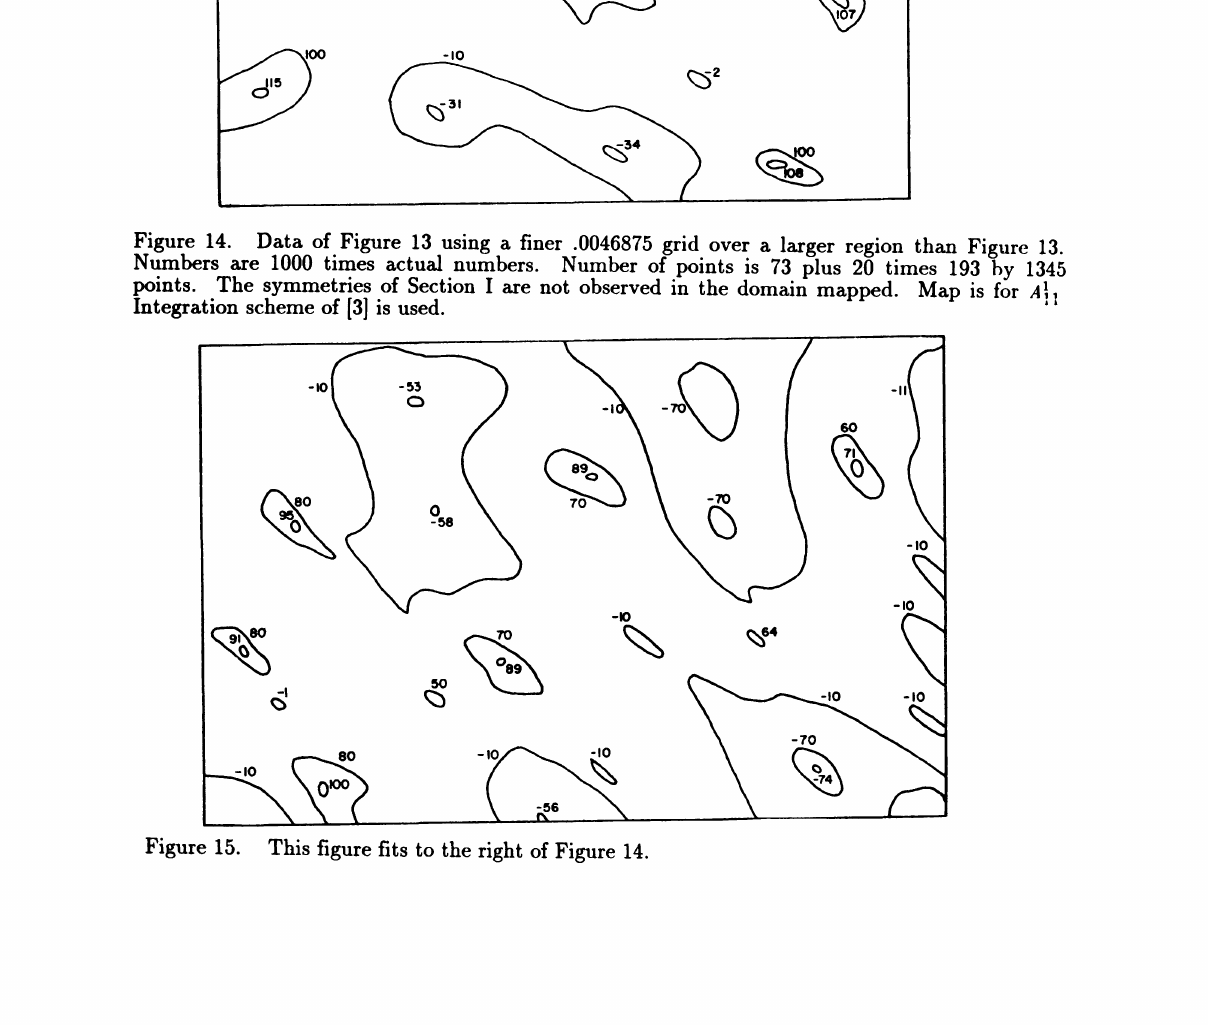
Figure 15. This figure fits to the right of Figure